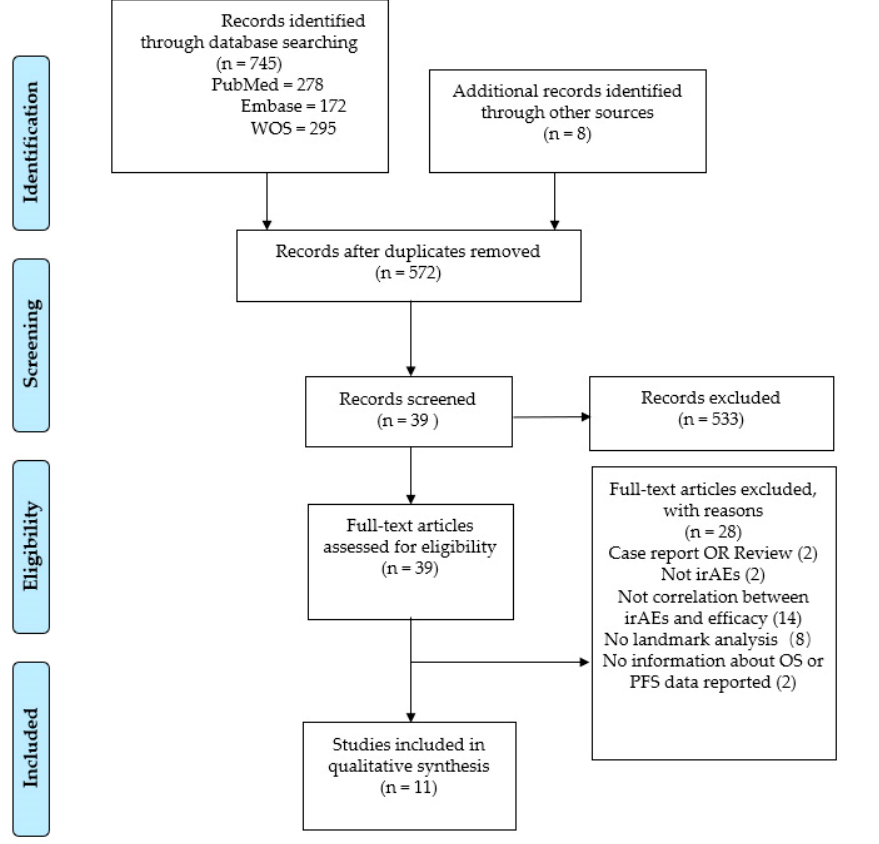
Figure 1. The flow